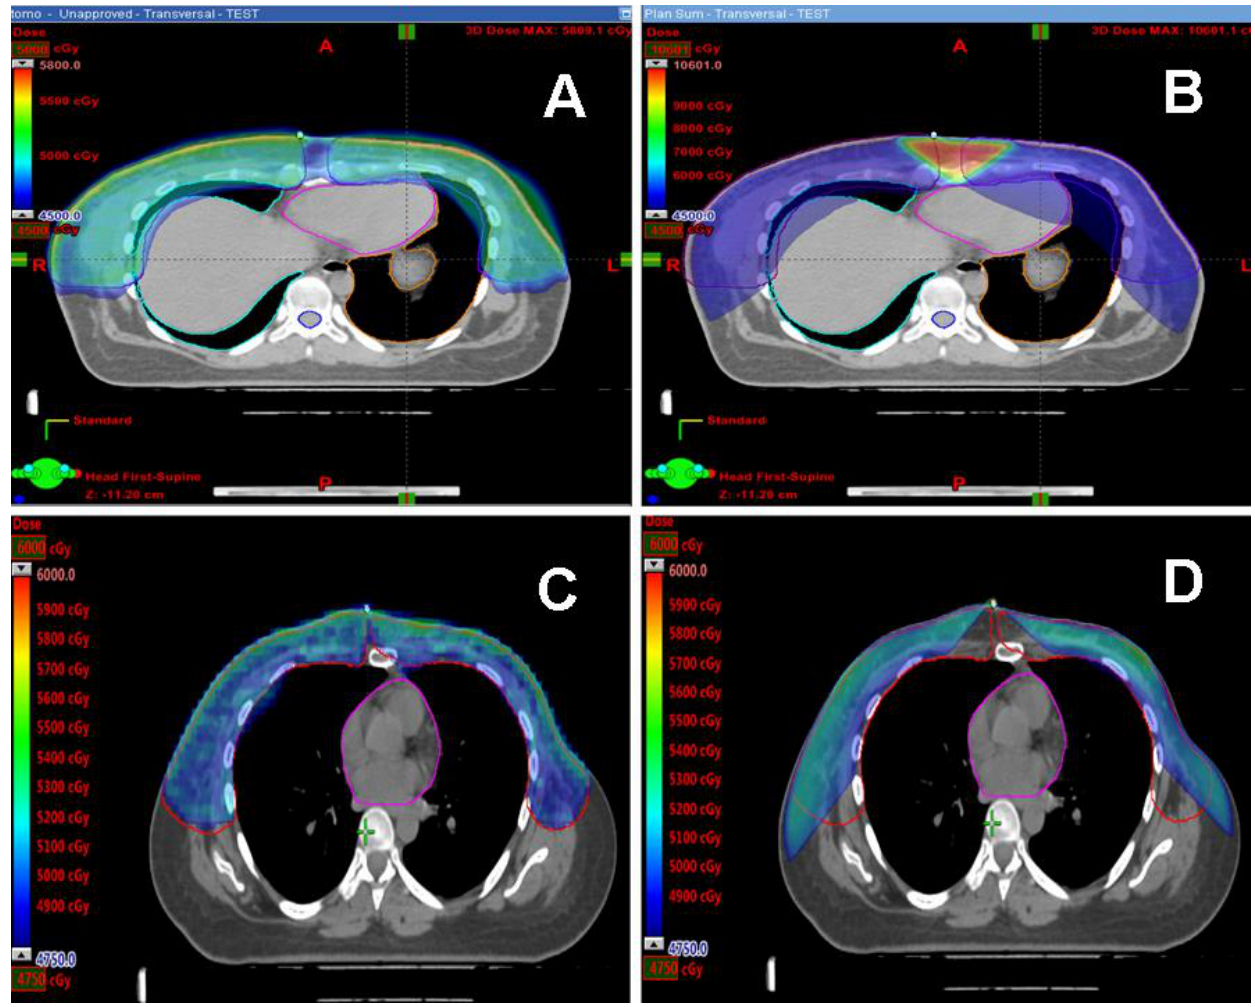
Figure 1: Dose distribution comparison between the 2 plans in 2 cases. In an attempt to have adequate PTV coverage in case number 1, 3D-CRT plan (1B) shows unacceptable high doses in the overlapping area compared to HT (1A) . In an attempt to avoid unacceptable high doses in case number 2, 3D-CRT plan (1D) shows compromised target coverage compared to HT